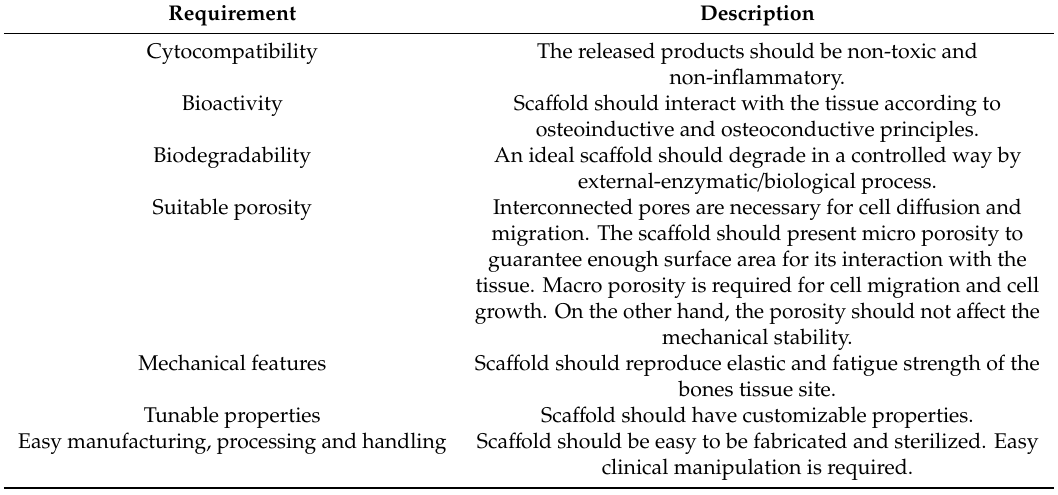
Table 3. Sca ff old requirements for e ff ective bone tissue